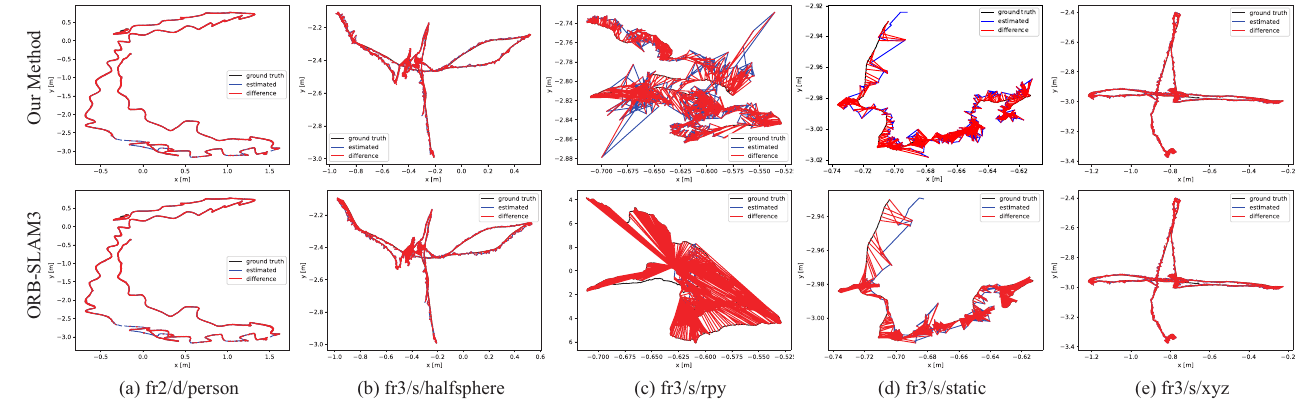
Figure 7. Comparison of ATE results between our method and ORB-SLAM3 in slightly dy- namic